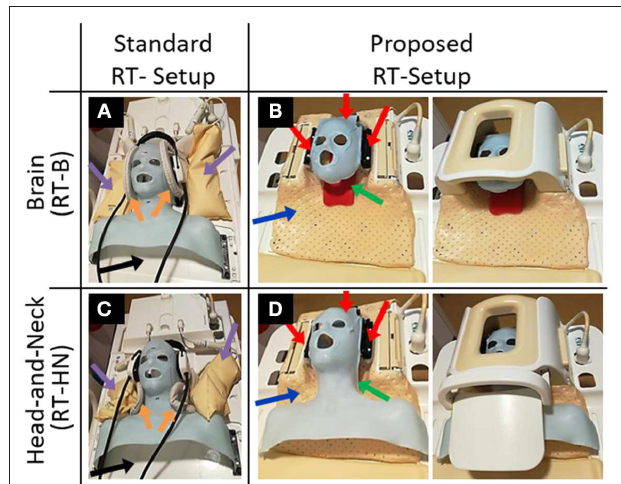
FIGURE 1 | Standard and proposed setups for MR imaging in treatment position for brain (A,B) and head-and-neck (C,D) radiotherapy patients. The blue arrows indicate the newly designed thermoplastic holder. The red arrows indicate the anchor points of the immobilization masks. The green arrows indicate the neck support, which can be made